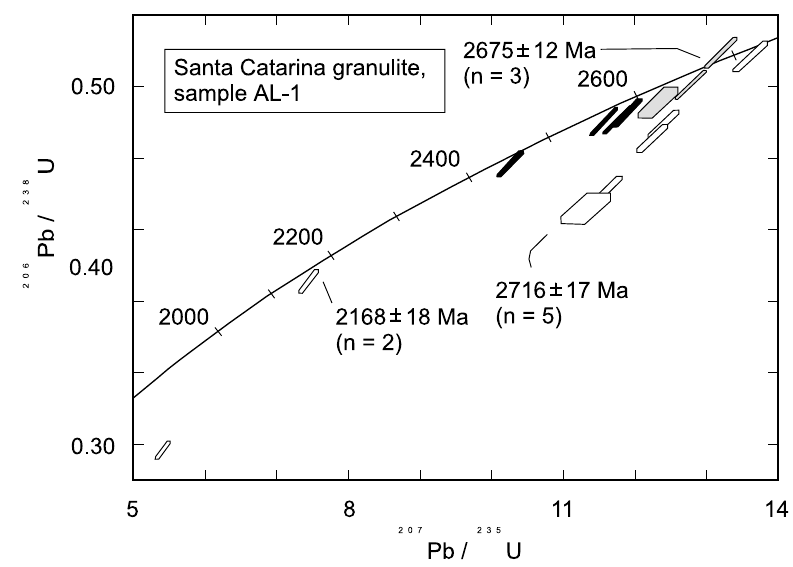
Fig. 3 – Concordia diagram of granulite, sample AL-1. Interpretation of magmatism (Archaean), M 1 granulite facies (Archaean) and M 2 + M 3 amphibolite + recurrent granulite facies (Paleoproterozic). Analytical spots close to 2.58 and 2.48 Ga are interpretedasleadlossduringthePaleoproterozoicevent. Manyspotsindicatemodern lead loss, because they align to 0 Ma. Oldest blank spots are interpreted as magmatic about 2716 Ma; youngest blank spots are interpreted as metamorphic M 3 about 2168 Ma; shaded spots are interpreted as metamorphic M 1 about 2675 Ma; black spots are interpreted as due to partial